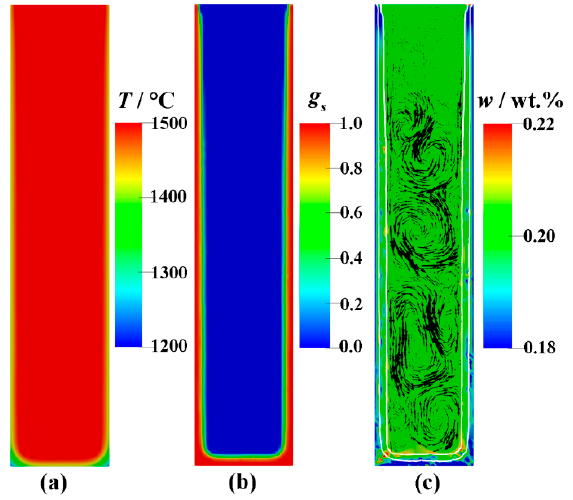
Figure 4. The predicted temperature ( a ), solid volume fraction ( b ), liquid velocity, and C concentration ( c ) of the steel ingot at the solidification time t = 100 s. The two white lines in ( c ) represent the solid volume fraction contours of 0.1 and 0.9.